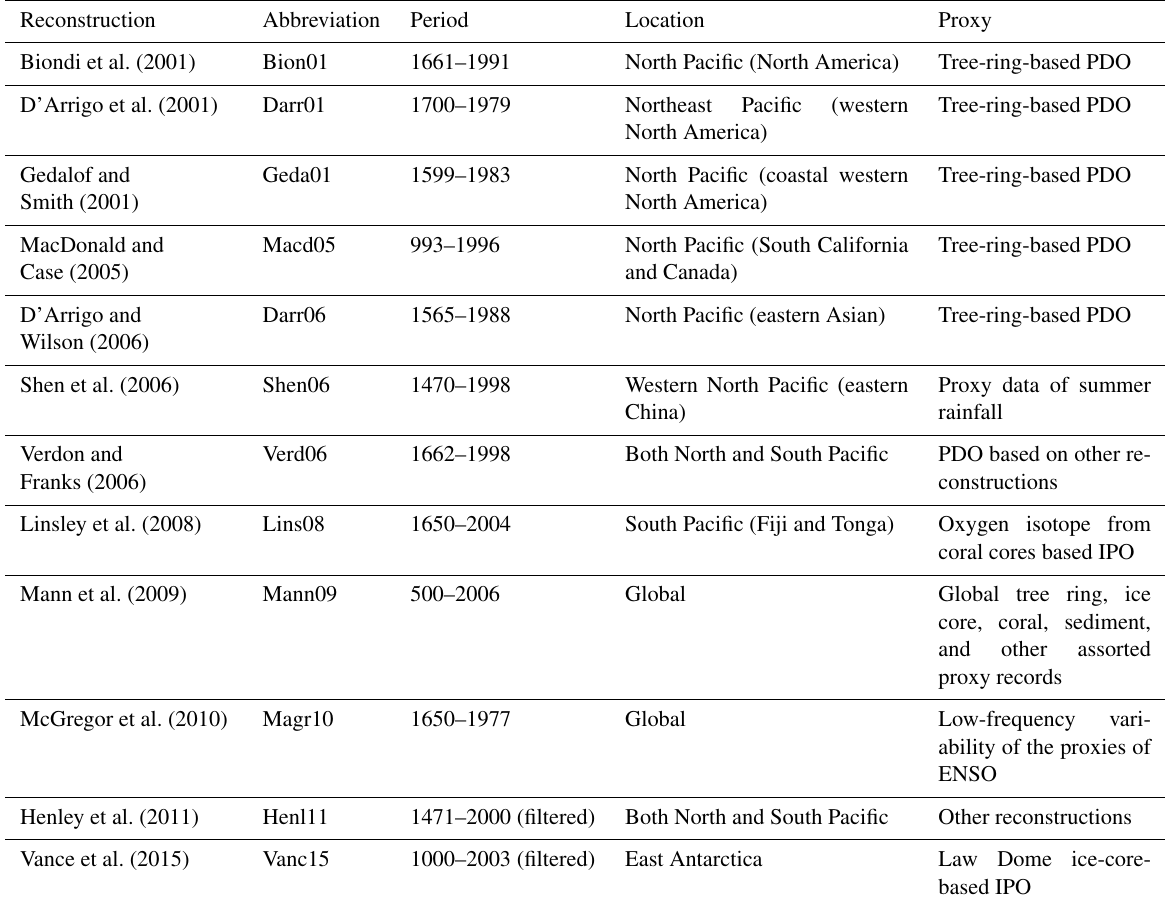
Table 1. Available PDV paleoclimate reconstructions and their descriptions.